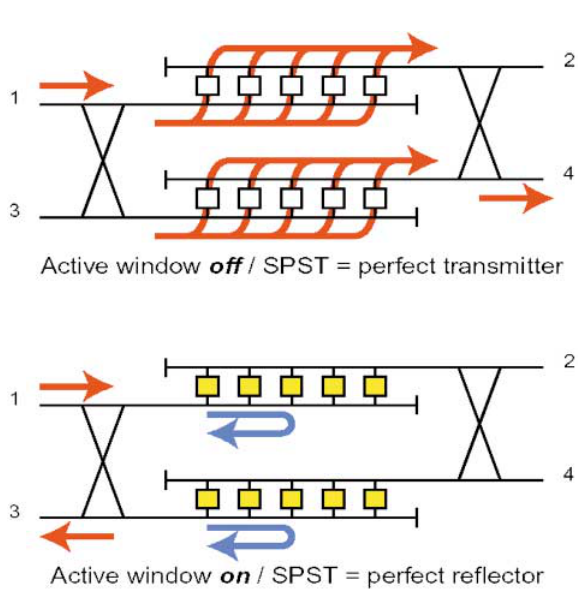
FIG. 4. The active